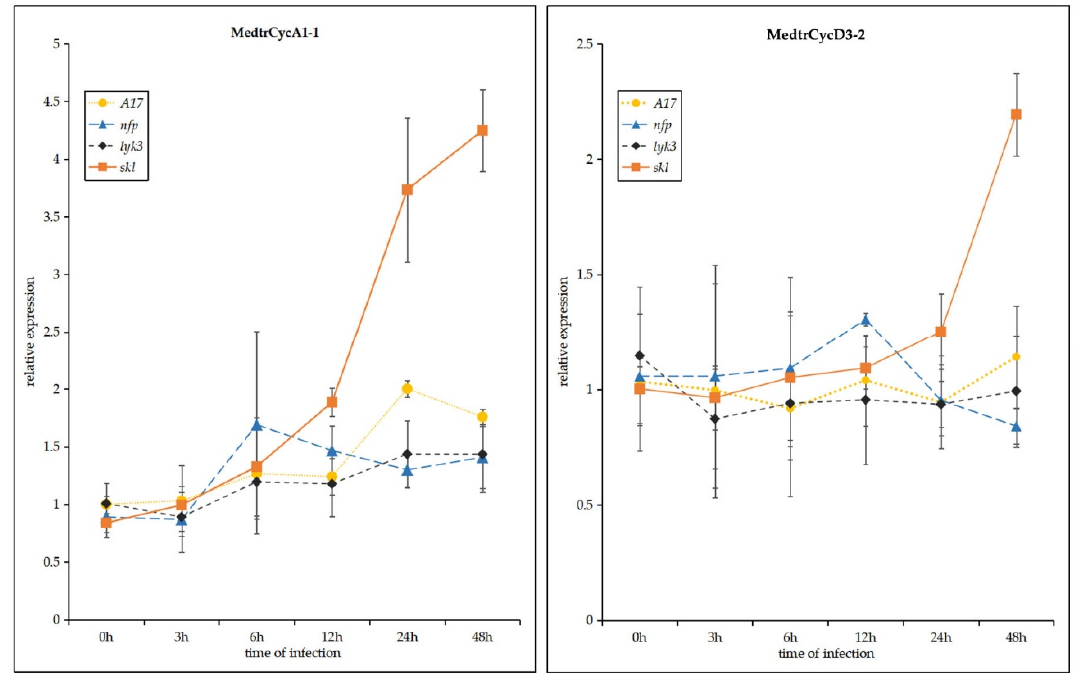
Figure 6. Expression profiles of Mtcyclin genes were analyzed after Sinorhizobium meliloti infection in four M. truncatula genotypes: wild-type A17, nfp , lyk3 and skl mutants. Values in the line graphs show average trimmed mean of M component (TMM) counts normalized to cv Jemalong A17 at 0 hpi. Error bars represent standard error (SE) calculated from three independent biological replicates.